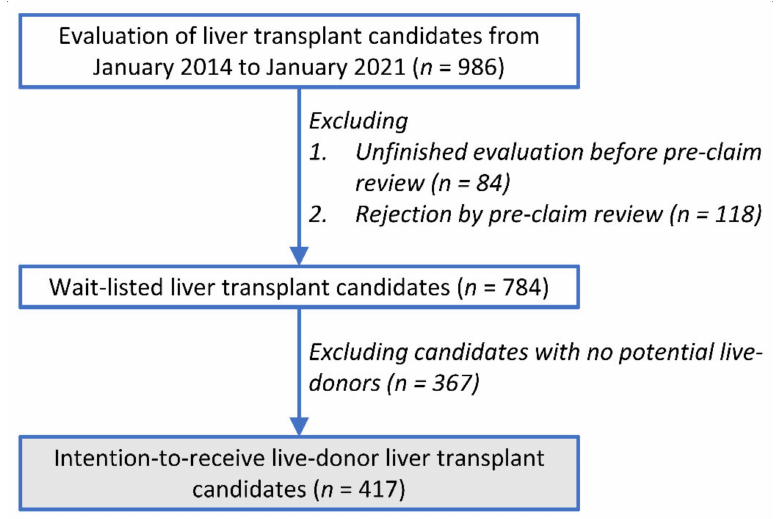
Figure 1. Patient flow